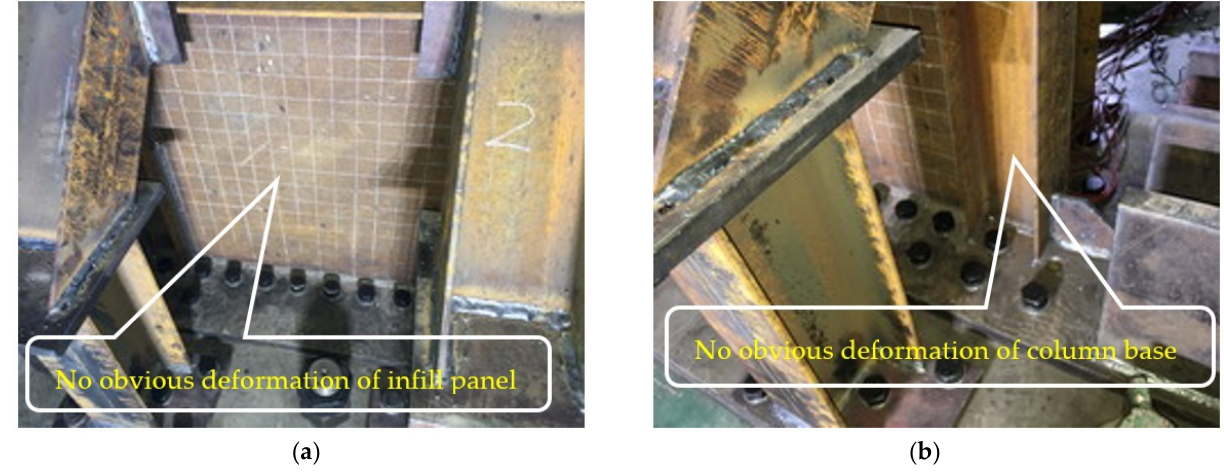
Figure 13. Deformation at the sixth loading level: ( a ) Infill panel; ( b ) Column base. At the eighth loading level, the maximum reaction force of the actuator forward loading was 423.5 kN with a displacement of 4.3 mm, while that for reverse loading was 530.4 kN with a displacement of 3.5 mm. The sound was significantly enlarged in the loading process and the frame column was still not yielded with the maximum out-of- plane displacement of 0.24 mm at the center of the infill